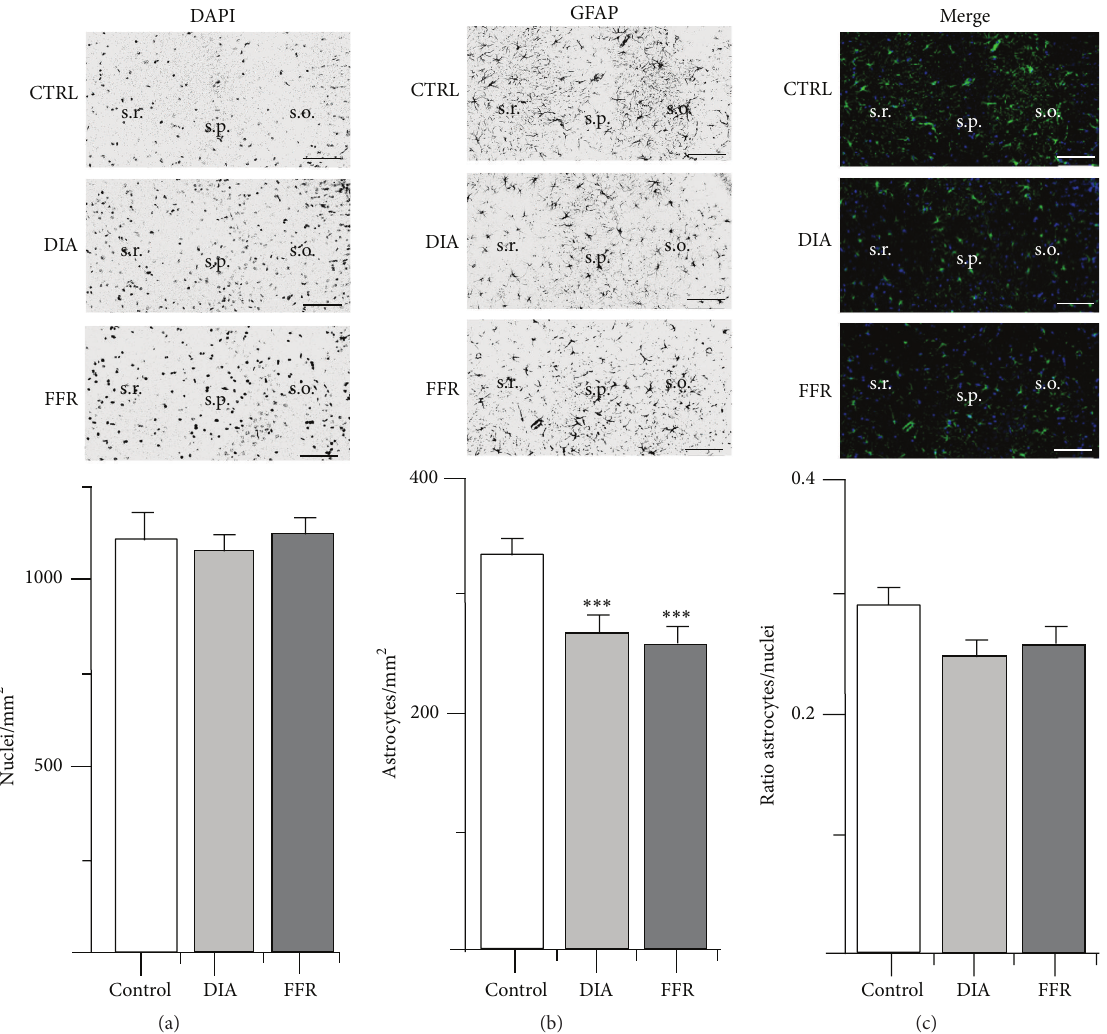
Figure 4: Effect of dehydration-induced anorexia (DIA) on astrocyte density of hippocampal region CA3. Coronal sections of the hippocampus show DAPI (a) or GFAP immunostaining (b). The overlay of DAPI and GFAP is shown for control, dehydration-induced anorexia (DIA), and forced-food restricted (FFR) experimental groups (c). Neither the density of nuclei nor the astrocyte/nuclei ratio differed significantly among groups ( 𝑝 = 0.931 and 𝑝 = 0.347 , resp.). However, a significant reduction of GFAP+ cell density was observed ( 𝑝 < 0.001 ) (see Table 1). Nuclear and astrocyte densities were estimated in the stratum oriens (s.o.) and stratum radiatum (s.r.); stratum pyramidale (s.p.) is indicated as an anatomical reference. Scale bar = 50 𝜇 m. Data are expressed as mean ±